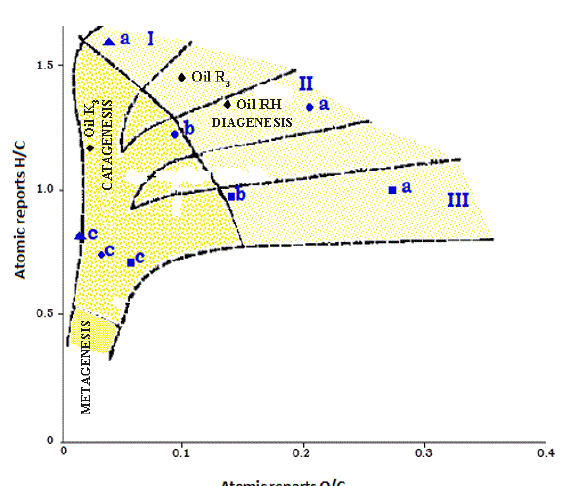
Fig. 2. Classification of the oils extracted from the shale materials by the Van Krevelen